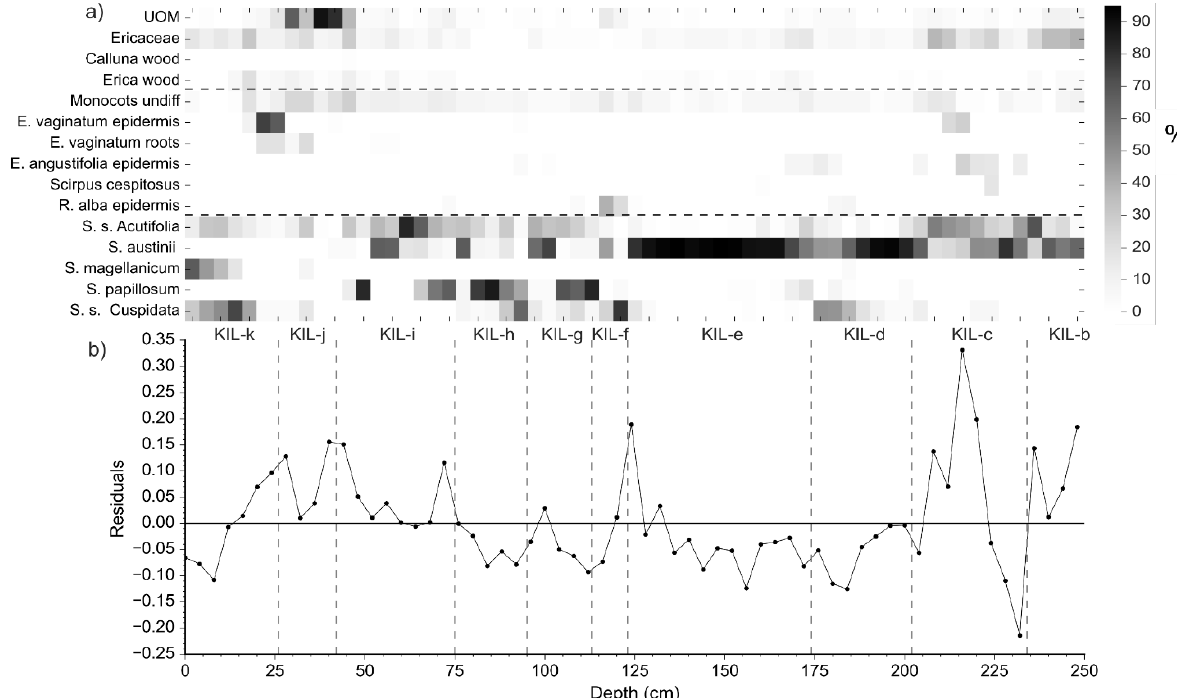
Figure 5. Heatmap of plant macrofossil percentage abundance (a) and detrended humification (b) for Killorn Moss with zones from the macrofossil record